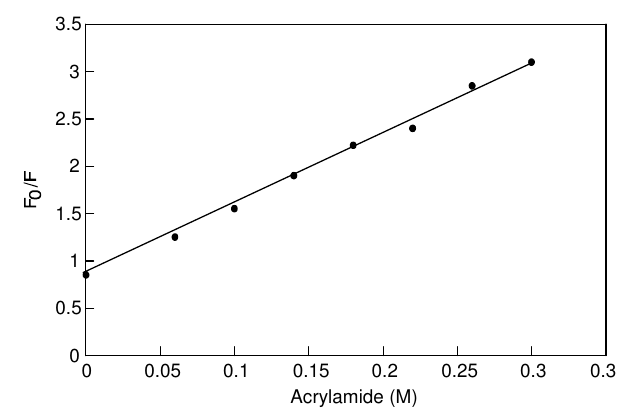
Figure 4 . Stern Volmer plot for Acrylamide quenching of sLP fluorescence.